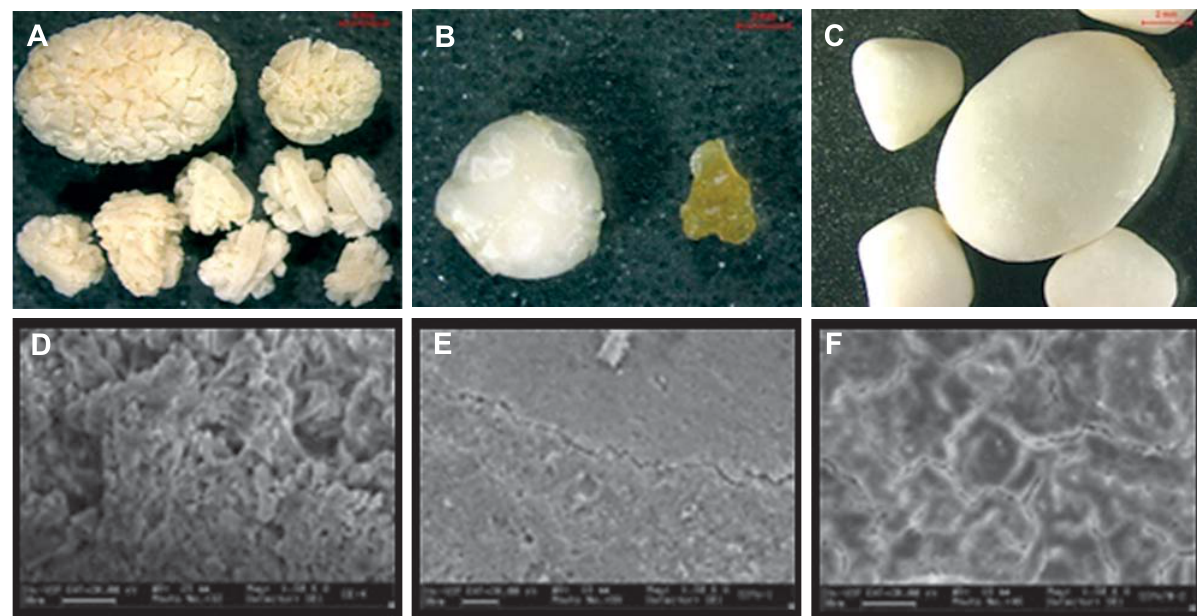
Figure 3 – Upper and lower panels show the stereomicroscopy and scanning electronic microscopy respectively of the calculi taken from animals untreated (A and D), animals treated from the beginning (B and E) and from later treated animals (C and